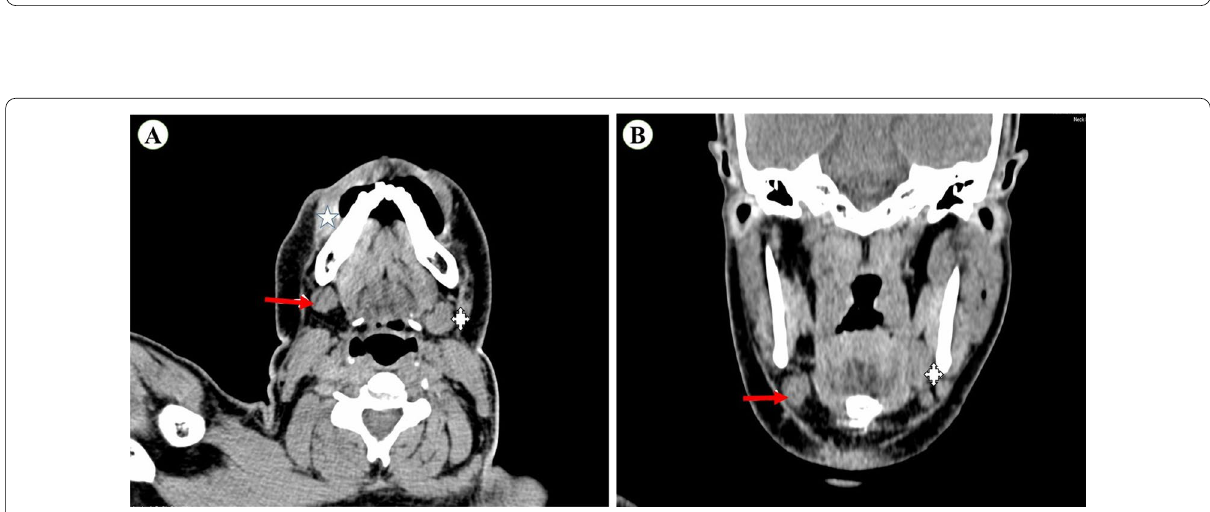
Fig. 4 CT scan neck plain— A Axial B coronal CT images revealing normal left submandibular gland (quad arrow callout— A , B ) and enlarged lymph node in the right submandibular fossa (arrow— A , B ). Right buccal mucosa mass also observed (star— A , B ). No bone erosion was seen. Right sublingual gland hypertrophy not well seen on CT